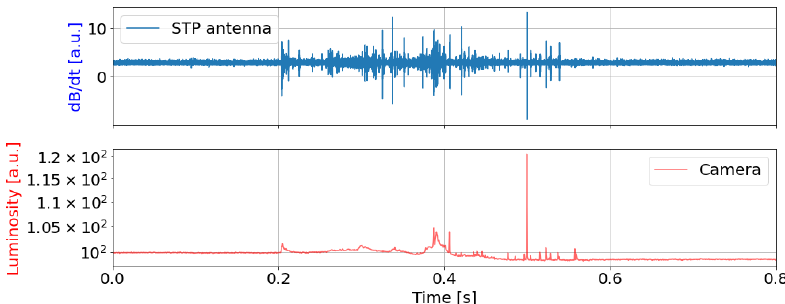
Figure 12. An example of data from the STP antenna and a comparison with camera